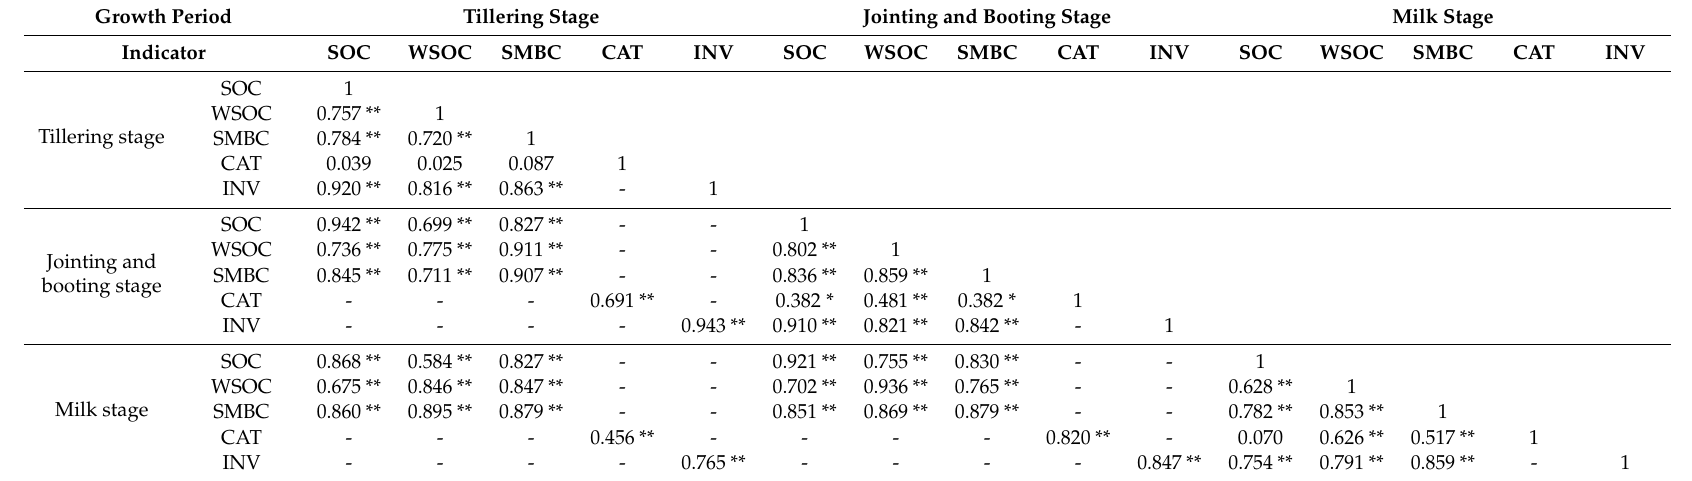
Note: * and ** indicate significant correlation at the 0.05 and 0.01 levels,